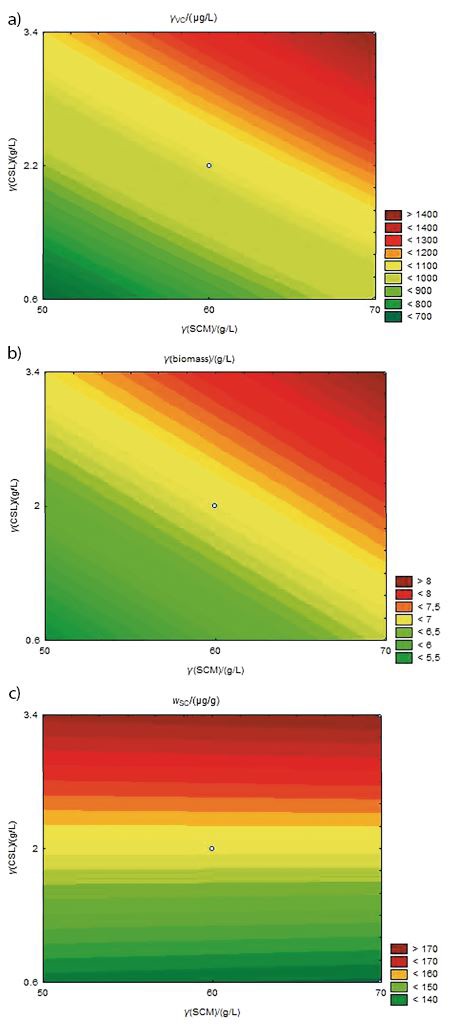
Contour curves of: a) volumetric carotenoid concentration, b) biomass concentration obtained by CCD and c) specific carotenoid concentration as a function of the corn steep liquor (CSL) and sugar cane molasses (SCM) concentrations